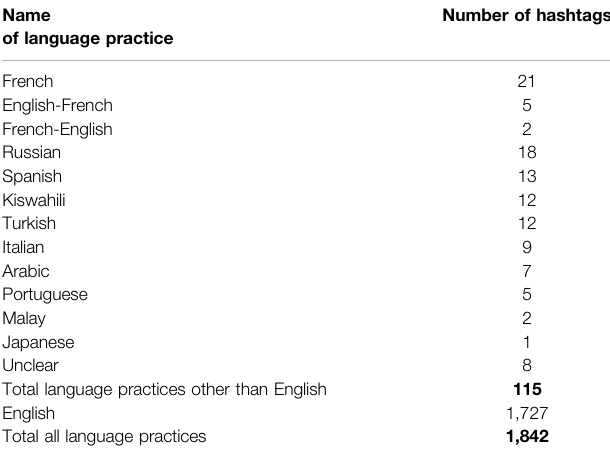
TABLE 1 | Language practices used in the hashtags. TABLE 2 | Semantic coding